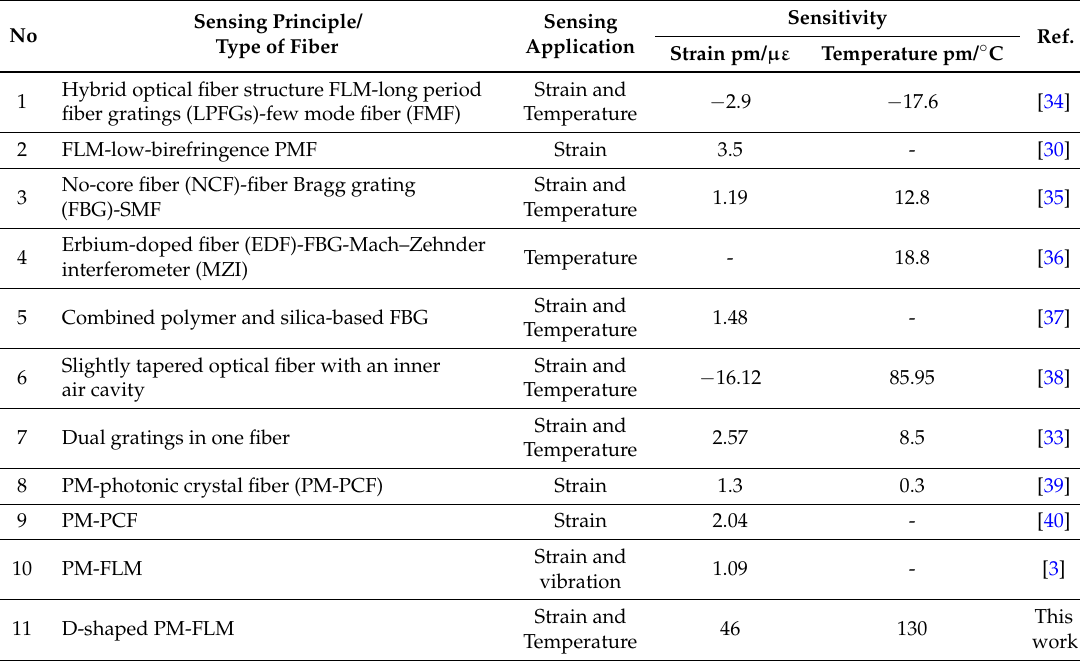
Table 3. Comparison of the sensitivity of the sensor presented in this work with other recently reported (mainly from 2013) FOSs for strain and